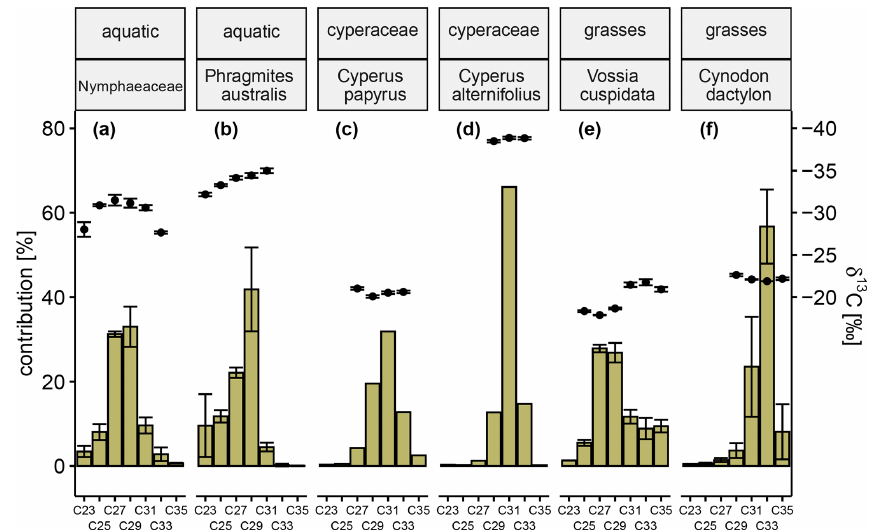
Figure 7. Green-colored bars show the relative concentration of long-chain, odd-numbered n -alkanes (C 23 –C 25 ) of Nymphaeaceae (a) , Phragmites australis (b) , Cyperus papyrus (c) , Cyperus alternifolius (d) , Vossia cuspidata (e) , and Cynodon dactylon (f) . Black circles represent corresponding carbon isotope values in reference to Vienna Pee Dee Belemnite (‰VPDB) of each n -alkane. Error bars represent the respective standard deviation. When several representatives of one species were analyzed (a, b, e, f) , the error bars reflect natural heterogeneity, while for the others they reflect the analytical uncertainty. When the analytical errors in repeated measurements are below 0.3‰, the intra-laboratory long-term error ( ± 0.3‰) is displayed instead. The same routine applies to n -alkanes if no repeated measurement was possible due to insufficient sample